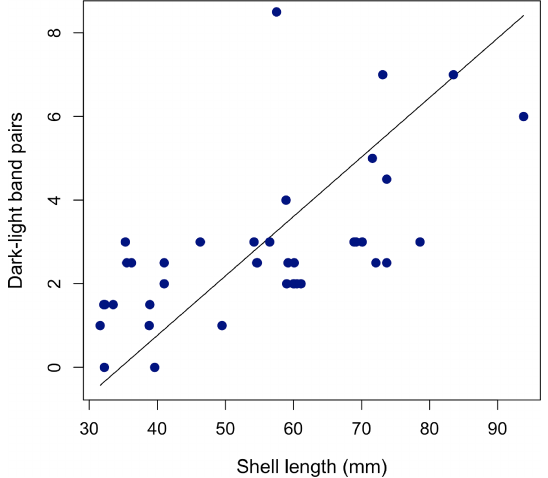
Figure 4. Relationship between shell length and number of growth band pairs for all 40 shells with an RMA regression line plotted. Number of dark–light pairs = 0.14 · shell length (mm) − 4.9.